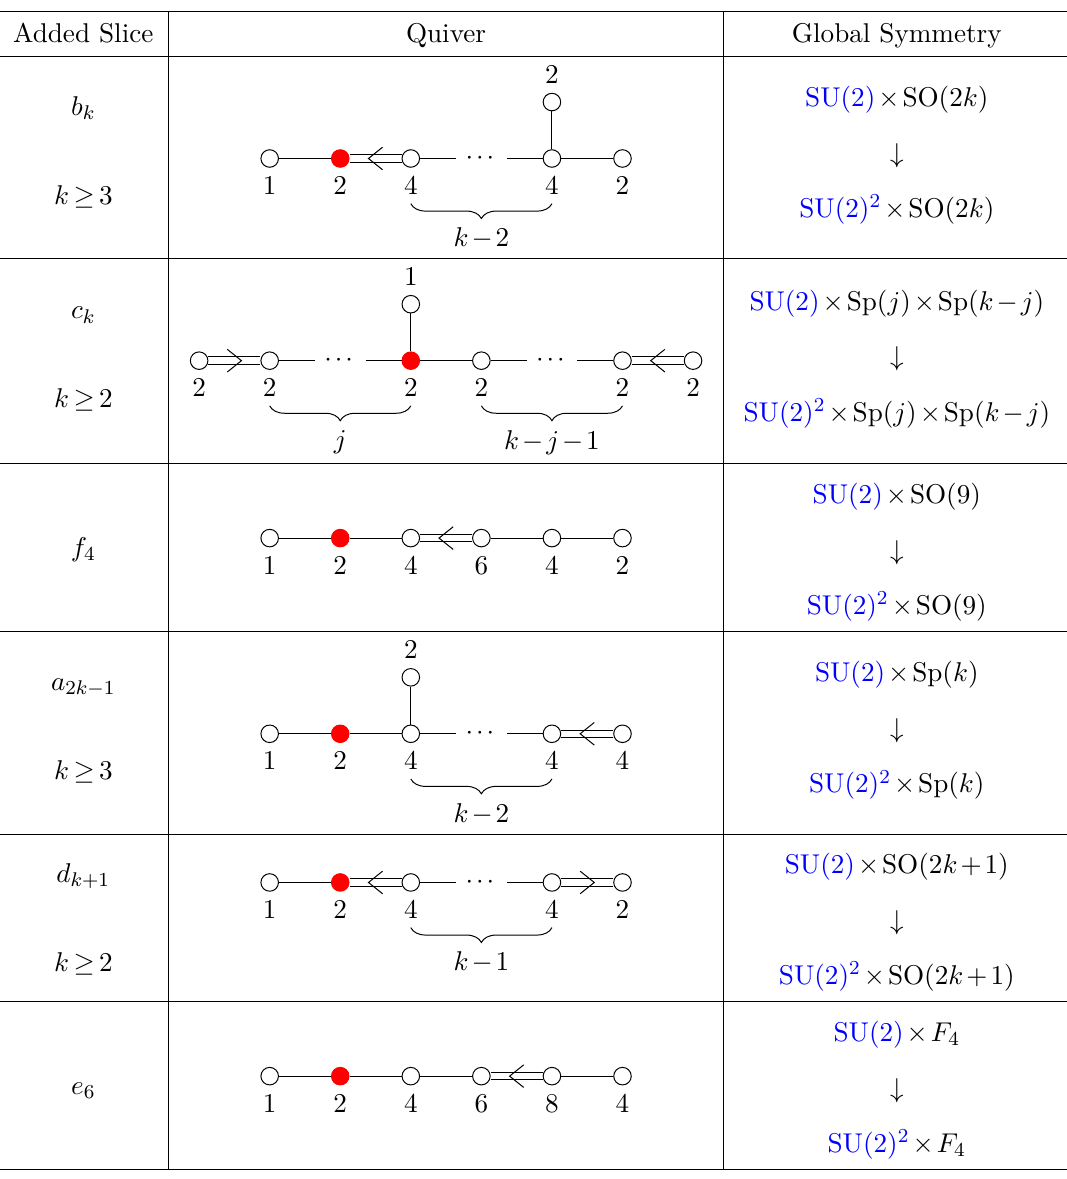
Table 19 . Quivers resulting from adding all possible elementary slices to n.min D 2 (6.6) to absorb a